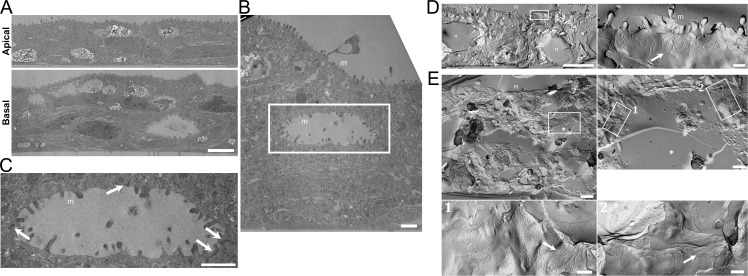
Transmission and freeze-fracture electron microscopy of MDCK I cells under the ‘Apical’ and ‘Basal’ conditions.(A) Transmission electron micrographs in a vertical section of MDCK I cell sheets at low magnification under the ‘Apical’ and ‘Basal’ conditions. MDCK I cells were observed at four days after the culture under the ‘Apical’ and ‘Basal’ conditions. Cavities were observed within the multi-layered MDCK I cells under the ‘Basal’ condition. Scale bar = 5 μm. (B) A transmission electron micrograph in a vertical section of MDCK I cell sheets at high magnification under the ‘Basal’ condition. The structure of microvilli was observed at the surfaces of the cavities and apical cell membranes of the outermost cell layer. Scale bar = 1 μm. (C) An enlarged image in the region enclosed by the white line in the transmission electron micrograph (B). Plasma membranes between the adjacent cells were fused immediately below the surface of the cavity (arrows). Scale bar = 1 μm. (D) Freeze-fracture electron micrographs in a lateral view of MDCK I cells under the ‘Apical’ condition at low magnification (left panel) and high magnification (right panel). TJ strands were observed immediately below the microvilli (arrow). Scale bars = 5 μm for the left panel and 200 nm for the right panel. (E) Freeze-fracture electron micrographs in a lateral view of MDCK I cells under the ‘Basal’ condition at low magnification (upper left panel), an enlarged image in the region enclosed by the white line in the upper left panel (upper right panel), and further enlarged images in the regions enclosed by the white lines in the upper right panel (lower panels). TJ strands were observed immediately below the surface of the cavity within the multi-layered MDCK I cells (arrows). Scale bars = 5 μm for the upper left panel, 1 μm for the upper right panel, and 200 nm for the lower panels. m, microvilli; n, nucleus; *, cavity.